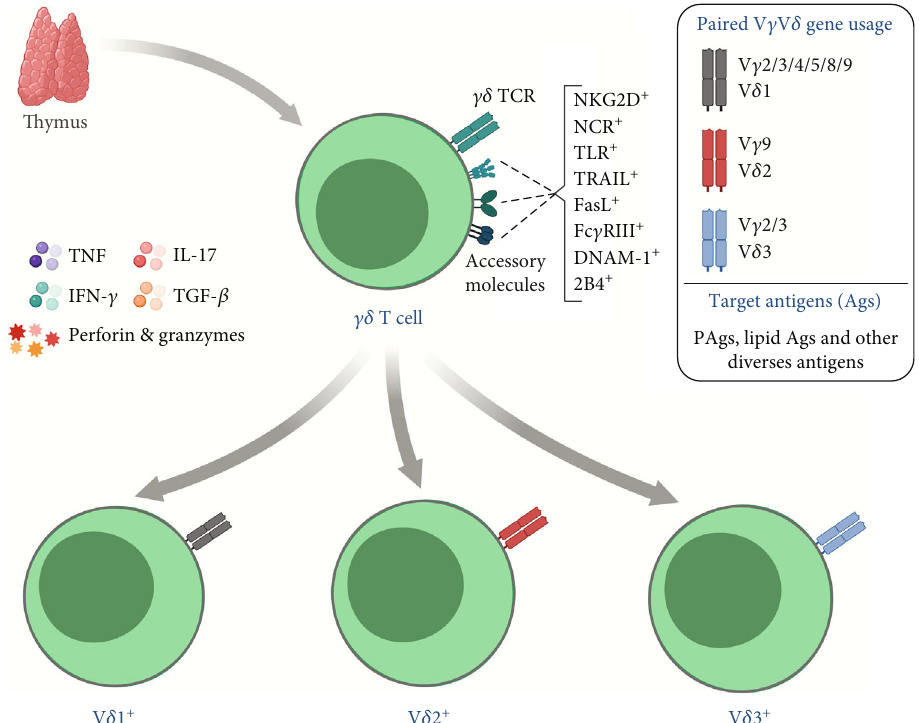
Figure 1: Overview of subpopulations, important receptors, and cytokines produced by γδ T cells. γδ T cells express some receptors that are essential for the tumor recognition and destruction, which gives a certain advantage when compared to other conventional T lymphocyte populations, either due to MHC independence or due to the high expression of the receptors mentioned in the image. The antileukemic recognition repertoire includes several molecules, such as NKG2D, NCRs, FasL, CD16, DNAM-1, and the TCR γδ